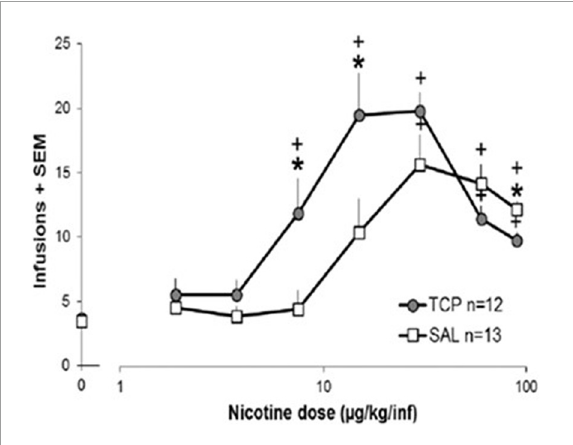
FIGURE2 Effect of MAO inhibition on nicotine self-administration in rats. Rats were treated with tranylcypromine (TCP, 1 mg/kg ip) or saline vehicle 1 h prior to the start of each daily 1-h nicotine self-administration sessions. Rats were tested with ascending doses of nicotine, with the dose increasing every 7 days. Data were analyzed as the average of the final 3 days on each dose for each rat (for details, see Smith et al., 2016, and this figure is reproduced from that publication). A significant difference ( p < 0.05) between the TCP group and the SAL group at a single dose is represented by ∗ and a significant difference from 0.0 ug/kg/infusion is represented by